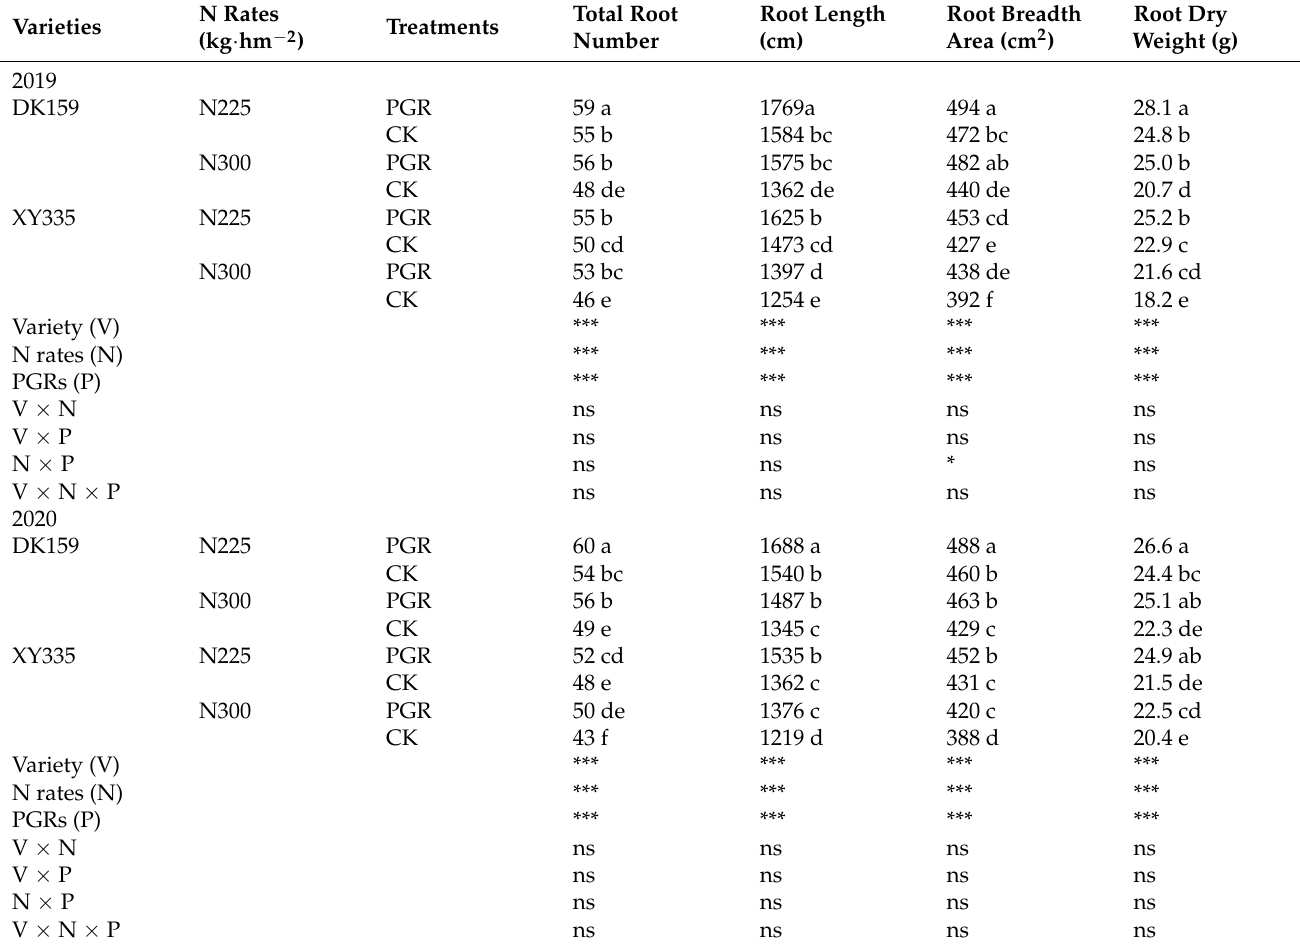
Table 3. Effects of PGRs and nitrogen fertilizer on the root characteristics of